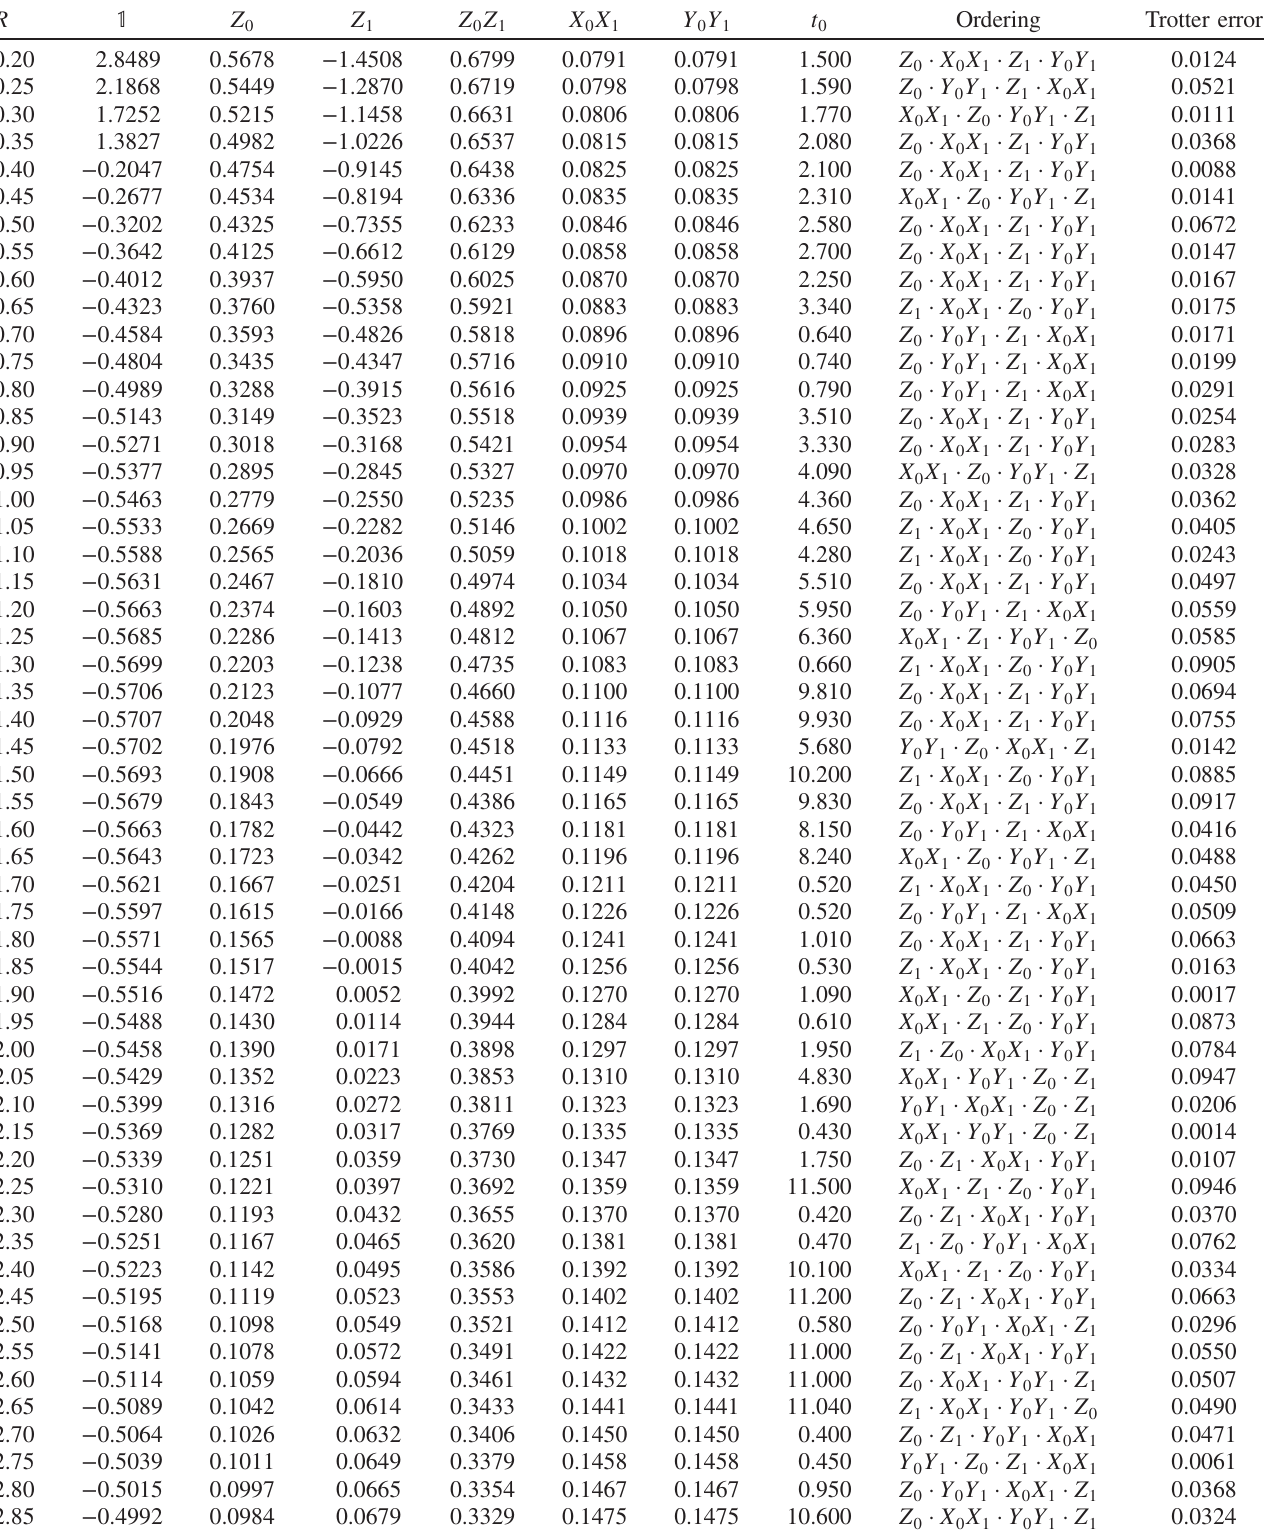
TABLE I. Hamiltonian coefficients for Eq. (1) and parameters for the PEA experiment for each value of R